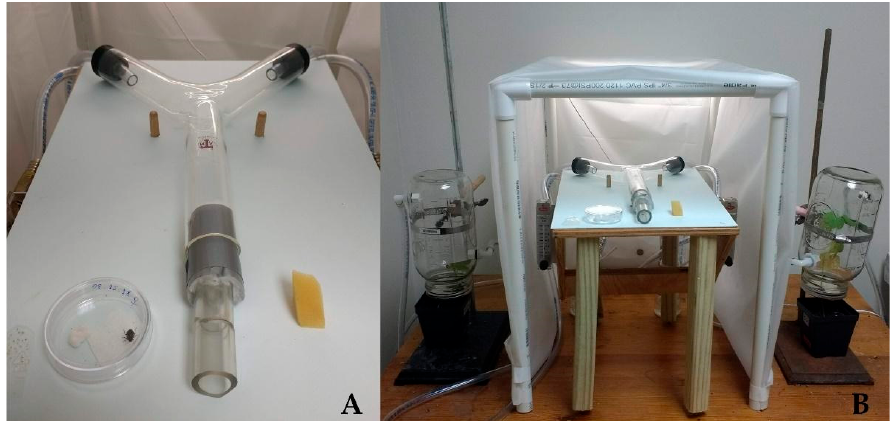
Figure 1. Y-shaped glass tube with the acclimation chamber ( A ) and the entire olfactometer setup showing the plant chambers ( B ).